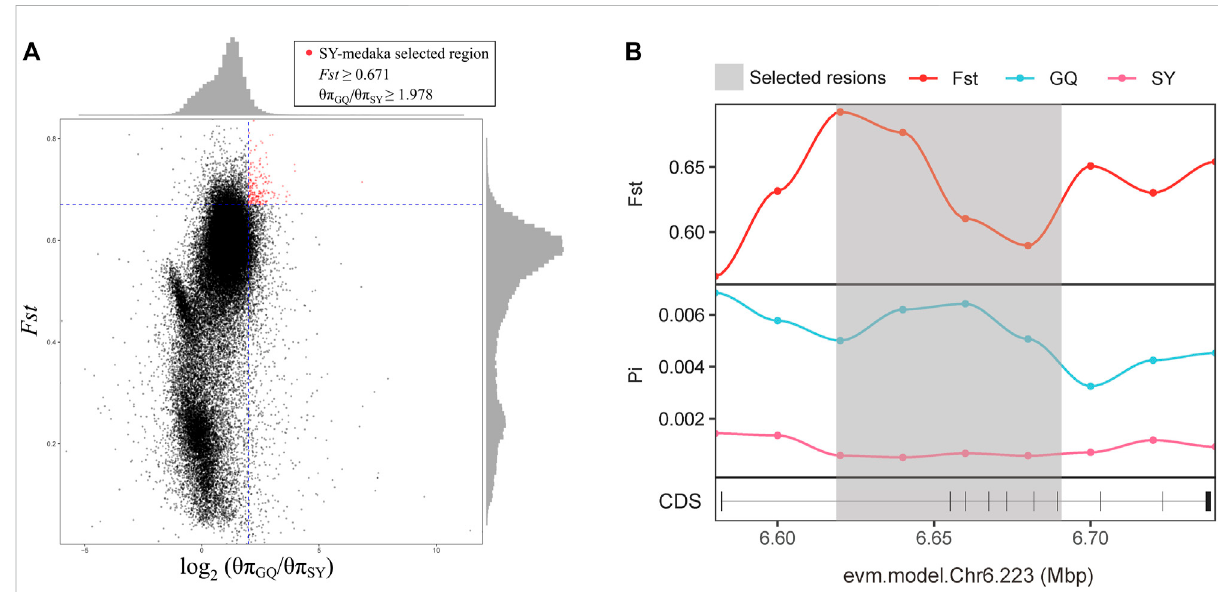
FIGURE 7 (A) The distribution of the θπ ratios ( θπ GQ-medaka/ θπ SY-medaka) and F ST values (GQ-SY), calculated in 20-kb windows sliding in 10-kb step. Data points on the right of the vertical dashed line (corresponding to the 5% left tail of the empirical θπ ratio distribution), and above the horizontal dashed line (5% right tail of the empirical F ST distribution) were identi fi ed as selected regions for SY-medaka (red points). (B) Examples of genes with strong selective sweep signals in GQ-medaka and SY-medaka. F ST and θπ values are plotted using a 10-kb sliding window. Shaded genomic regions were the regions with strong selective signals for SY-medaka.